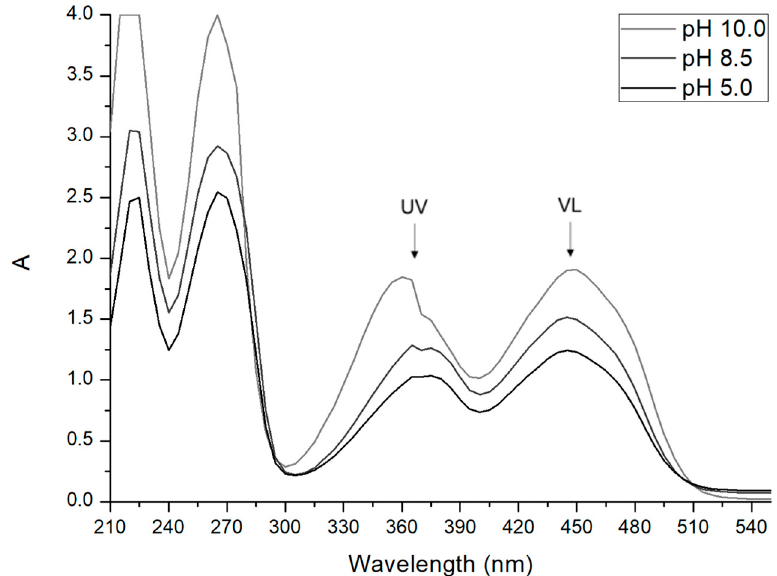
Figure 1. Riboflavin absorbance spectrum (210–550 nm) at different pH values. Wavelength values of 365 nm (UV light) and 450 nm (Visible light) are indicated with arrows.